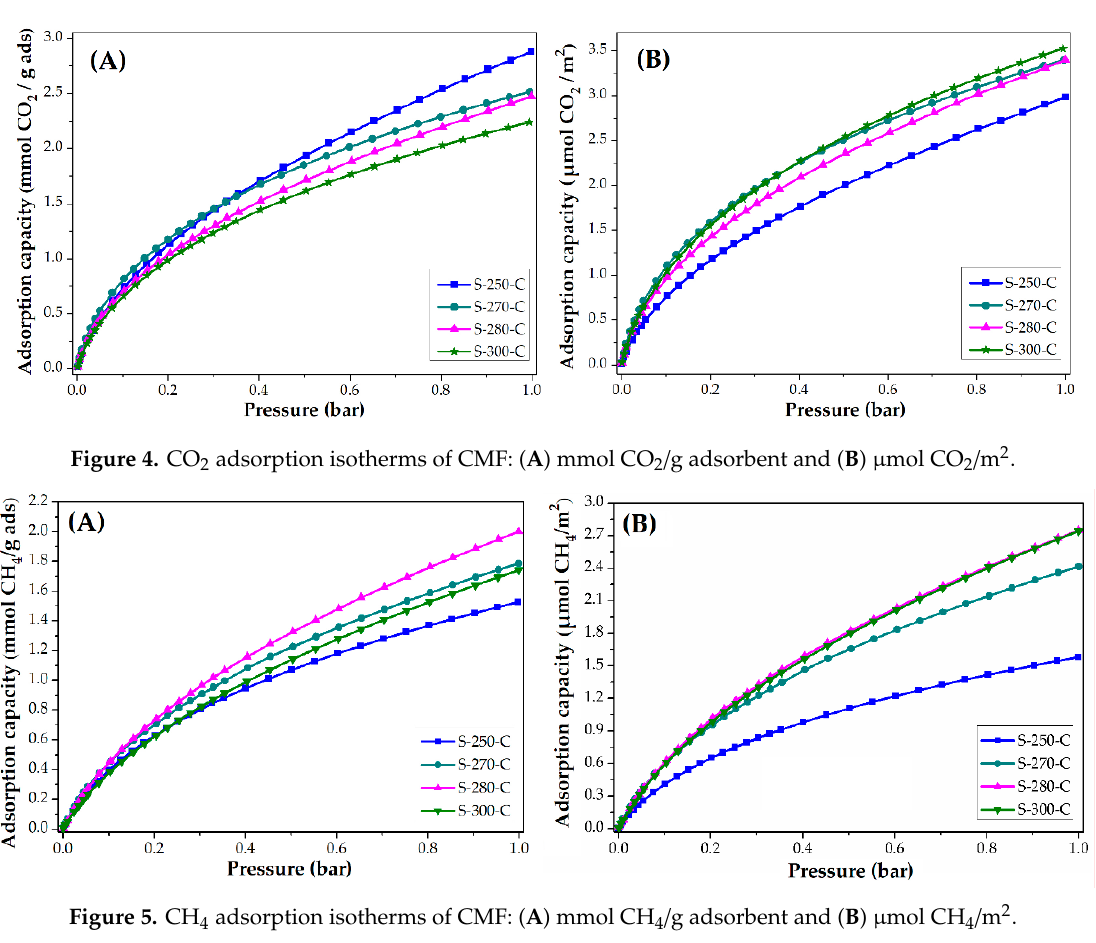
Figure 5. CH 4 adsorption isotherms of CMF: ( A ) mmol CH 4 /g adsorbent and ( B ) μ mol CH 4 /m 2 .